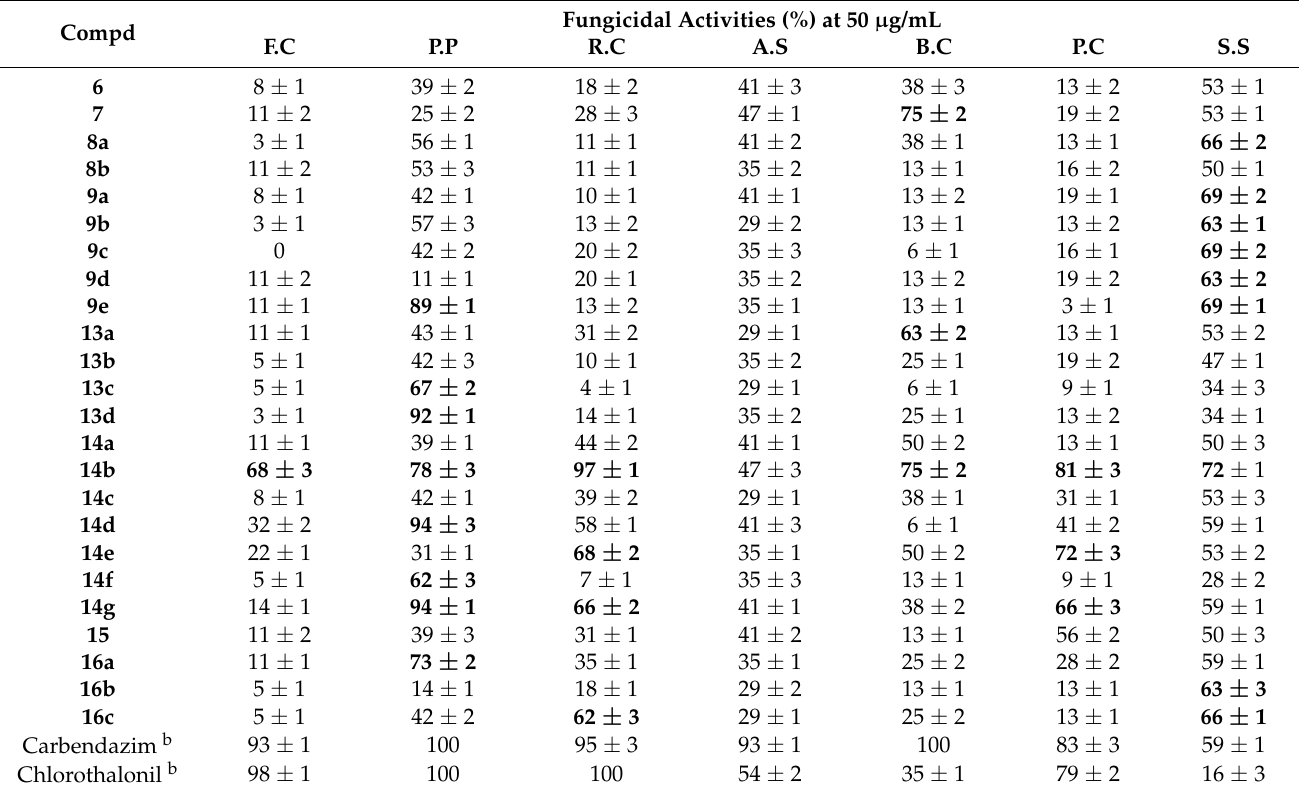
Table 2. In vitro fungicidal activities of compounds 6 , 7 , 8a – 8b , 9a – 9e , 13a – 13d , 14a – 14g , 15 , 16a – 16c , chlorothalonil and carbendazim against 7 kinds of fungi a